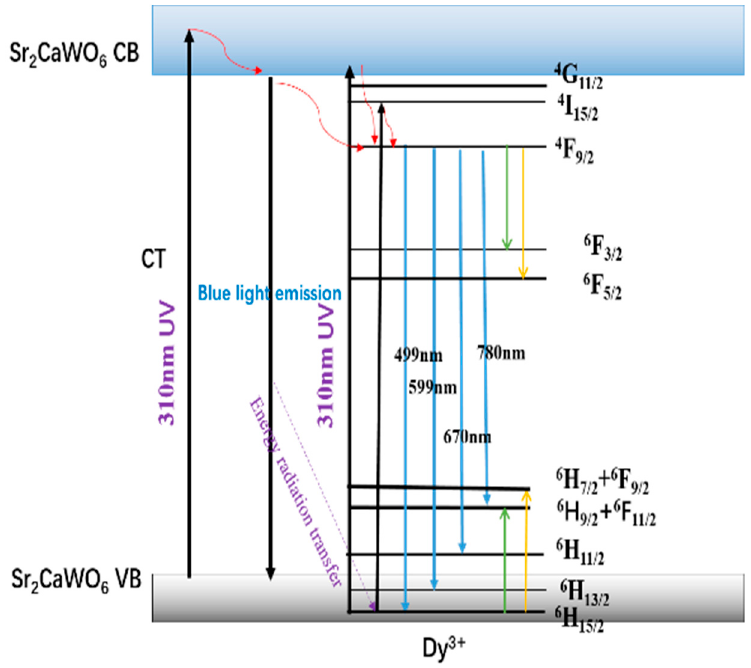
Figure 9. Schematic illustration of the energy transfer mechanism for Sr 2 CaWO 6 :Dy 3+ . The red solid curve with an arrow means the vibrational relaxation of excited Dy 3+ ion in Sr 2 CaWO 6 . The green solid line with an arrow and the yellow one means the cross relaxation 4 F 9/2 : 6 H 15/2 → 6 H 9/2 + 6 F 11/2 : 6 F 3/2 and 4 F 9/2 : 6 H 15/2 → 6 F 5/2 : 6 H 7/2 + 6 F 9/2 of Dy 3+ ions, respectively.